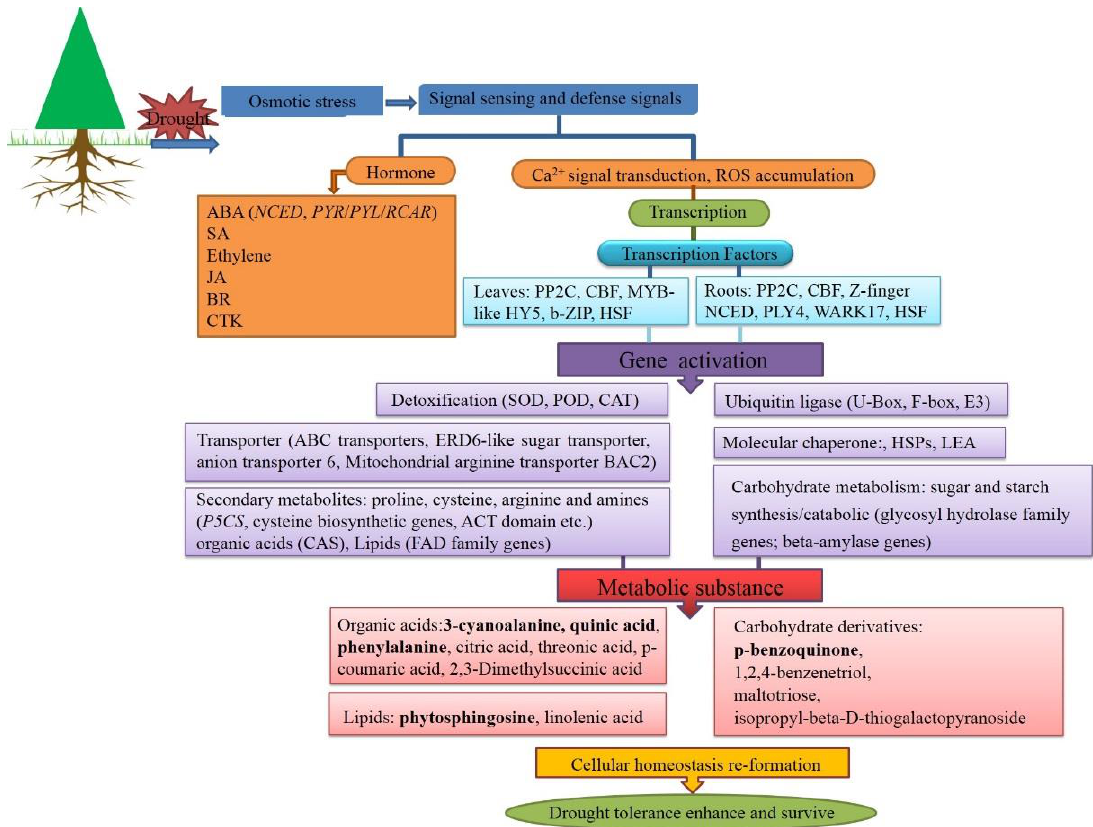
Figure 7. Deductive diagram of the drought-tolerant cherry rootstock P. mahaleb CDR-1. Supplementary Materials: The following are available online at www.mdpi.com/xxx/s1, Table